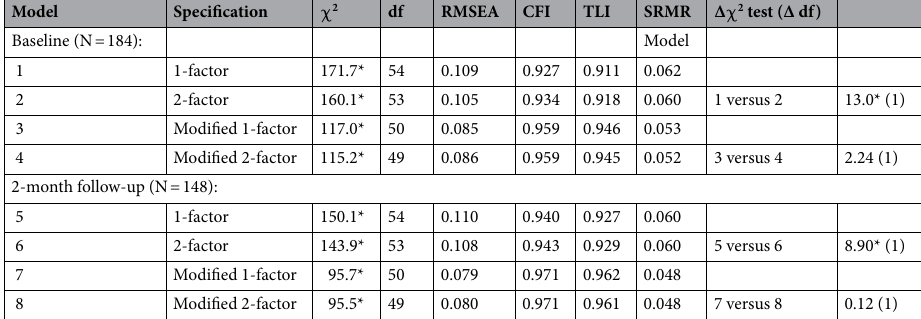
Table 3. Fit indices of confirmatory factor analysis models for the Stroke-Specific Quality of Life Scale at baseline and 2-month follow-up. * p < 0.01; df = degree of freedom; RMSEA = root mean square error of